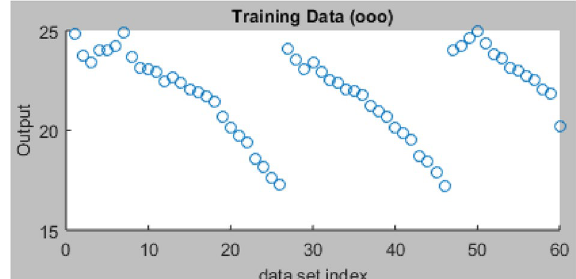
Figure 12. ANFIS model training graphical plot.